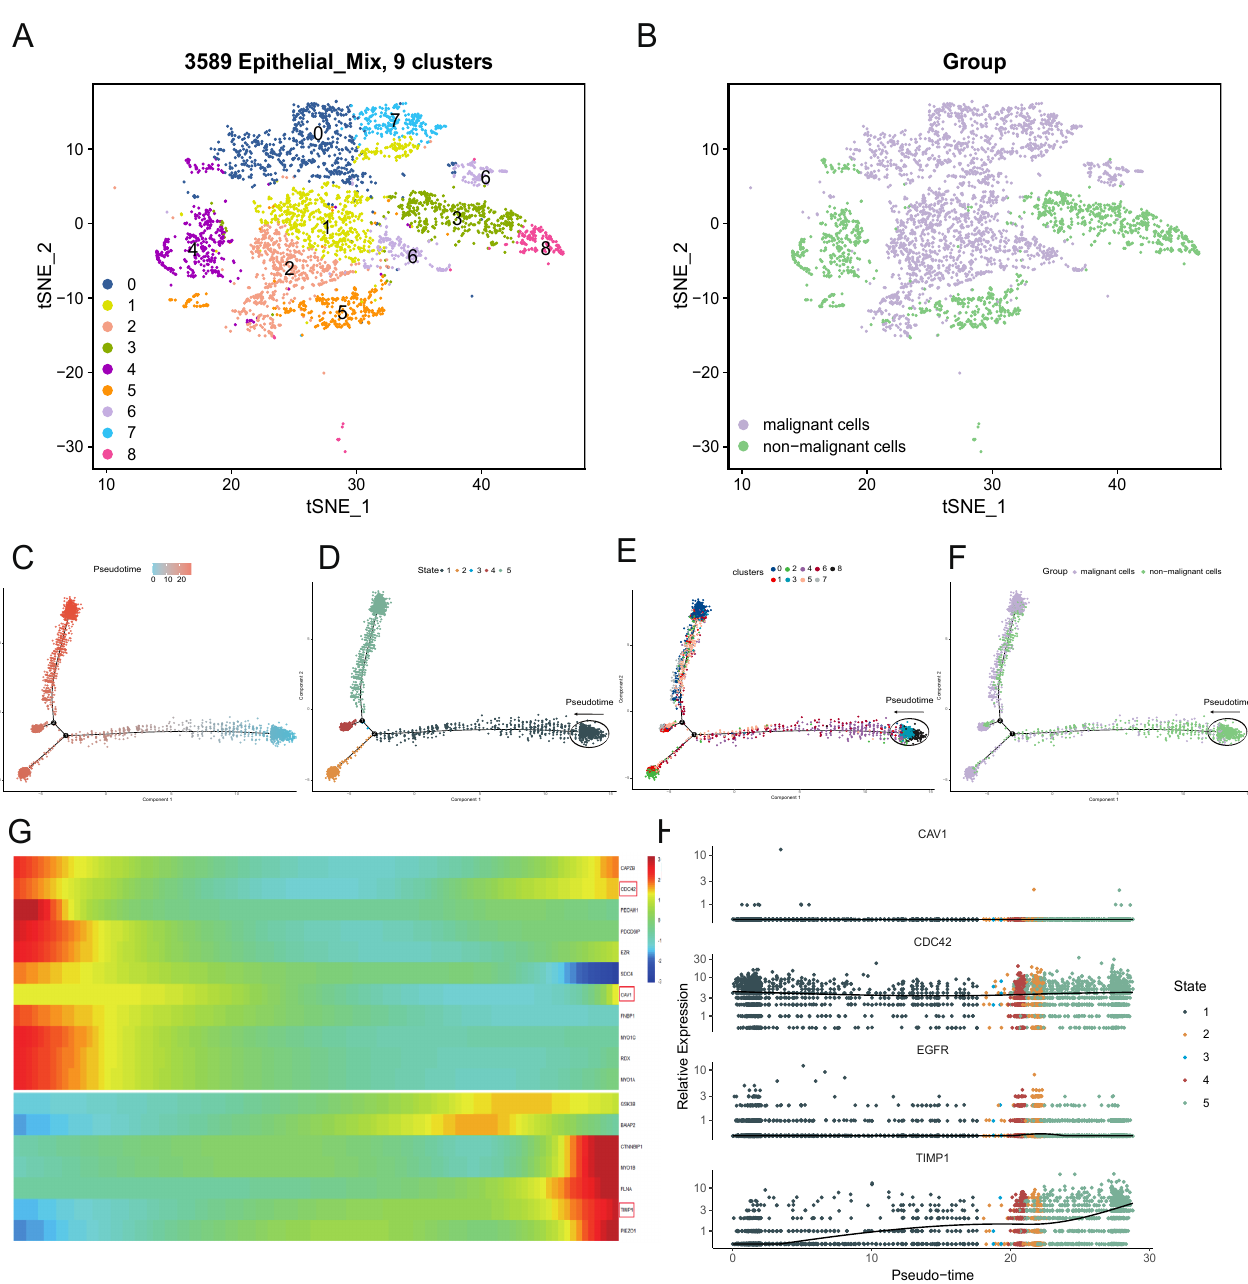
Figure 9. Epithelial cell clusters’ and pseudotime analysis. ( A , B ) t-SNE plot of 3589 epithelial cells, color-coded by their associated cluster ( A ) or cell classification ( B ). Note that the cell type was judged to be malignant by inferCNV analysis (Supplementary Figure S2). ( C – F ) Trajectory reconstruction ( C ) of all single cells from non-malignant to malignant epithelial cells; states ( D ), distribution of clusters ( E ), and cell types ( F ) on the trajectory are shown. ( G ) Heatmap showing time-series gene expression (rows) in epithelial cells (columns) for each membrane tension-related gene. ( H ) Gene expression dynamics of 4-MTRGs are